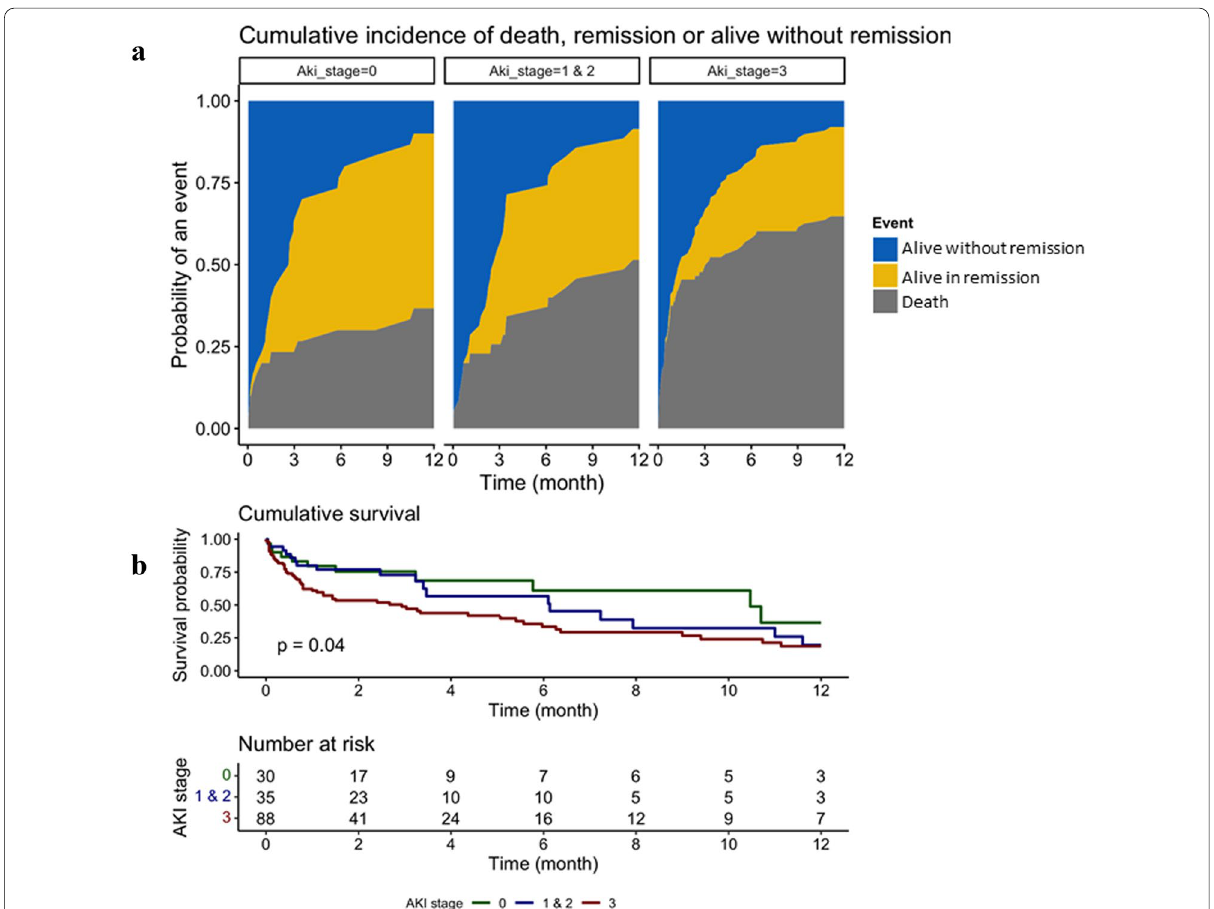
Fig. 2 a Cumulative incidence of remission according to AKI and taking into account competing risks. b Kaplan–Meier survival estimates according to AKI stage